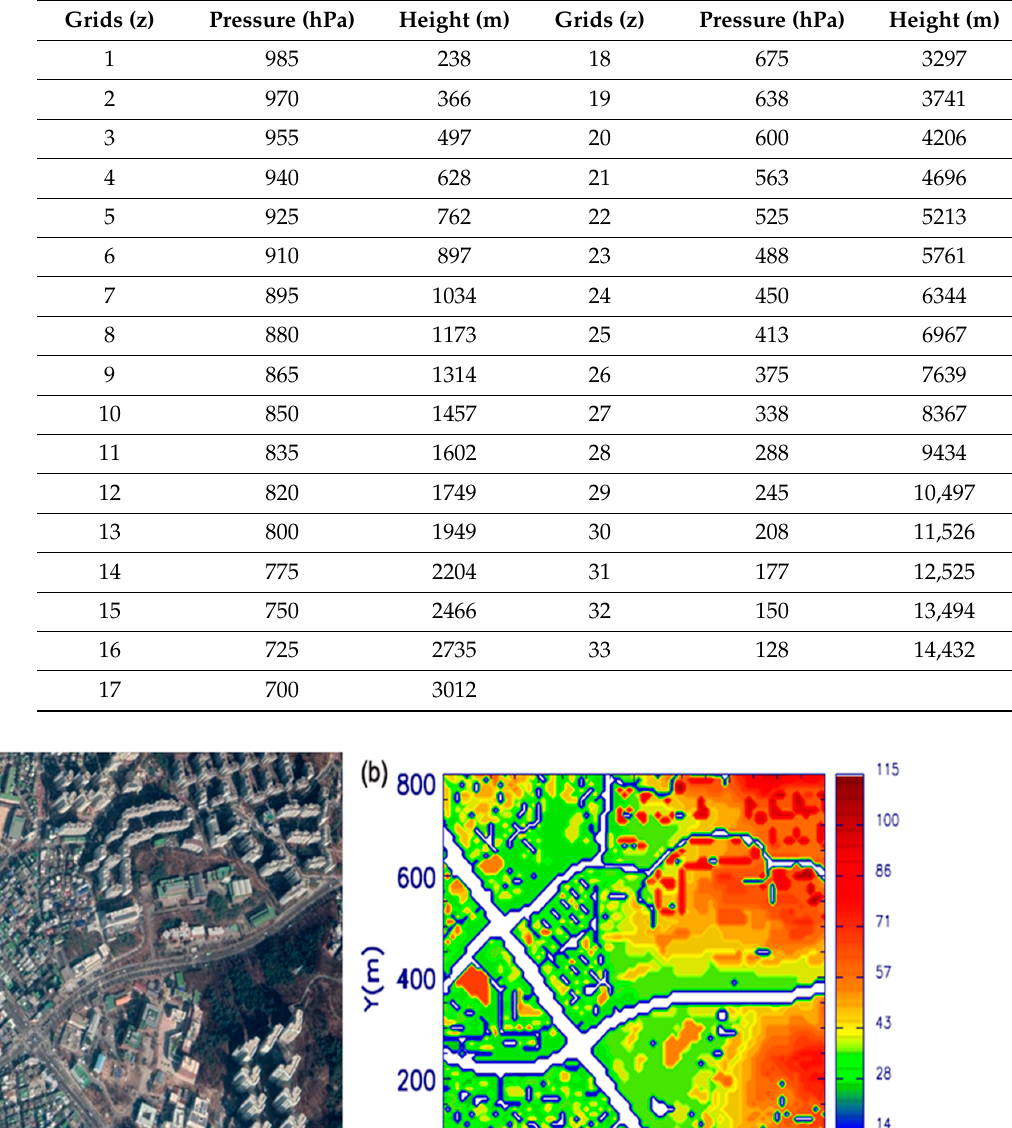
Table 2. Vertical grids of MERRA-2 and the computational fluid dynamics atmospheric chemistry model (CFD-Chem).